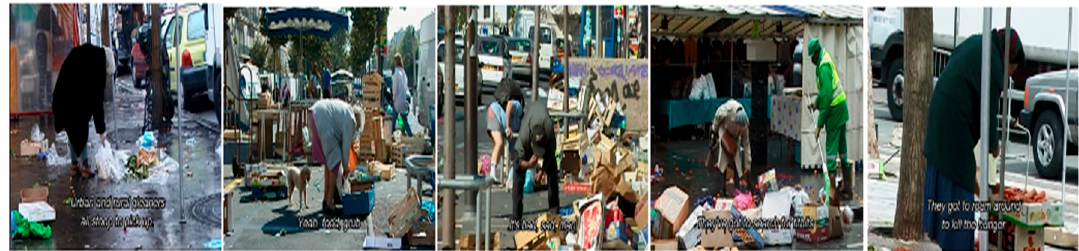
Figure 6. Varda shifts the camera from gleaner to gleaner in time to the music of the ‘Rap de récup’ soundtrack.